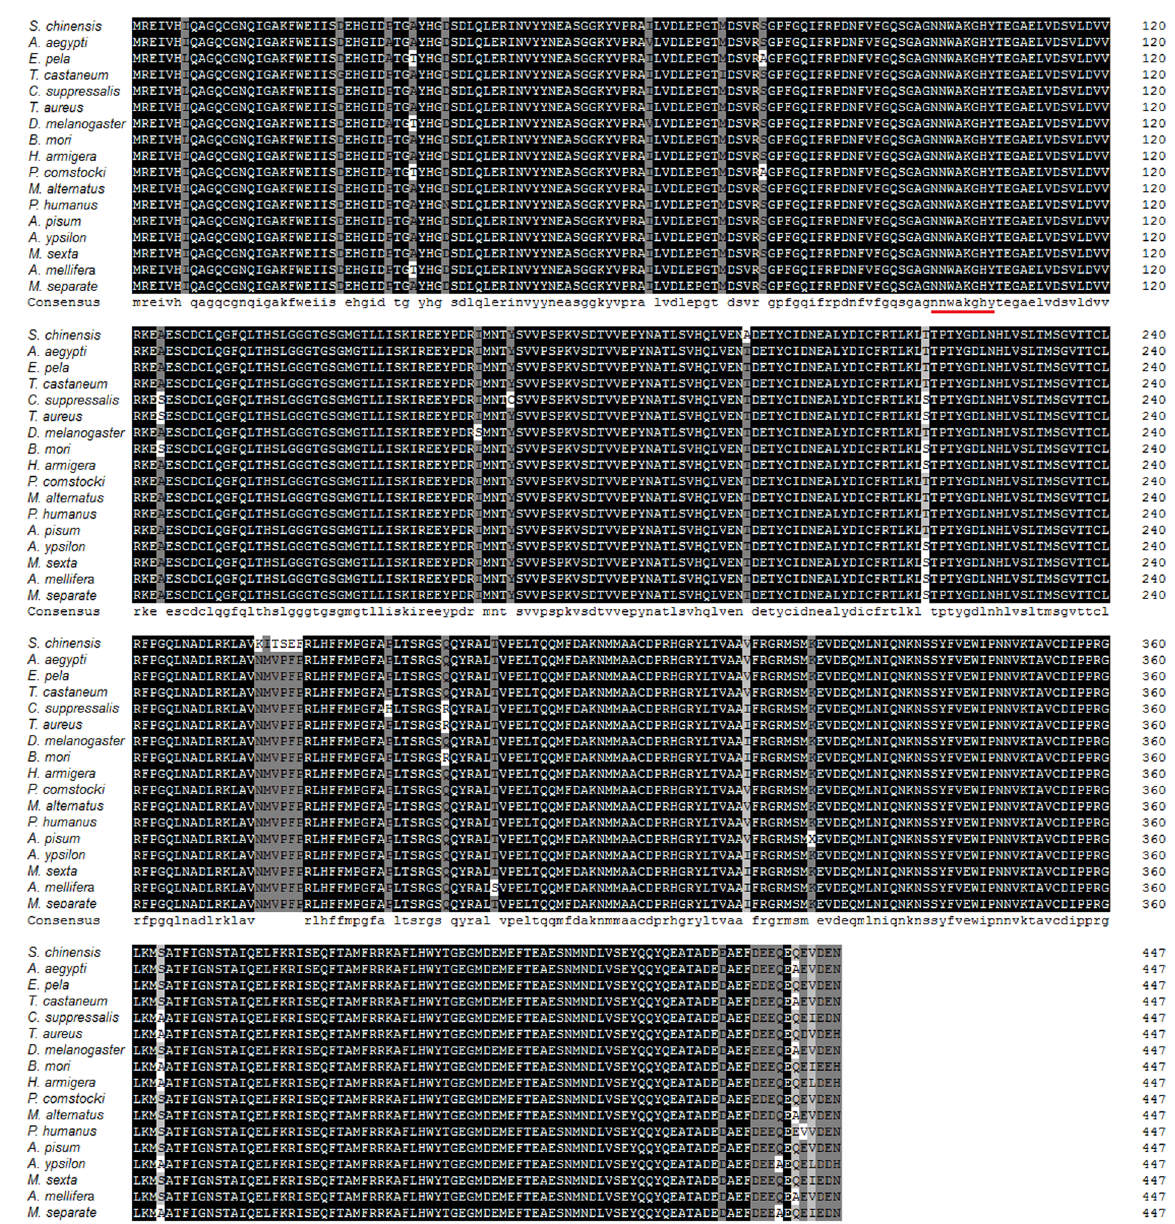
Figure 4. Amino acid sequence alignment of the predicted S. chinensis β -tubulin with homologs from other insect